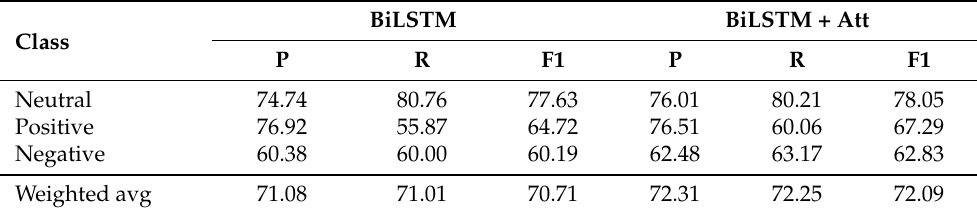
Table 6. Performance of BiLSTM w/o attention.